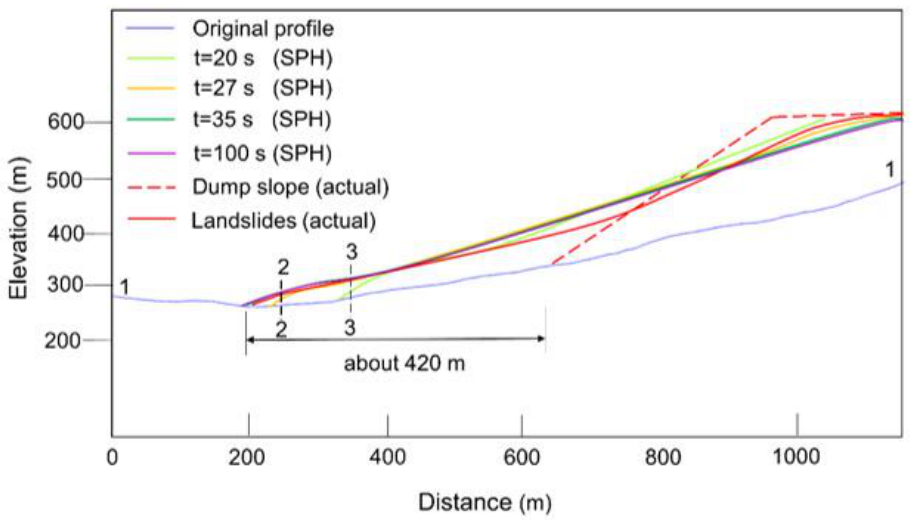
Figure 14. Comparison of profiles by the SPH simulation and the actual landslides along Section 1–1.